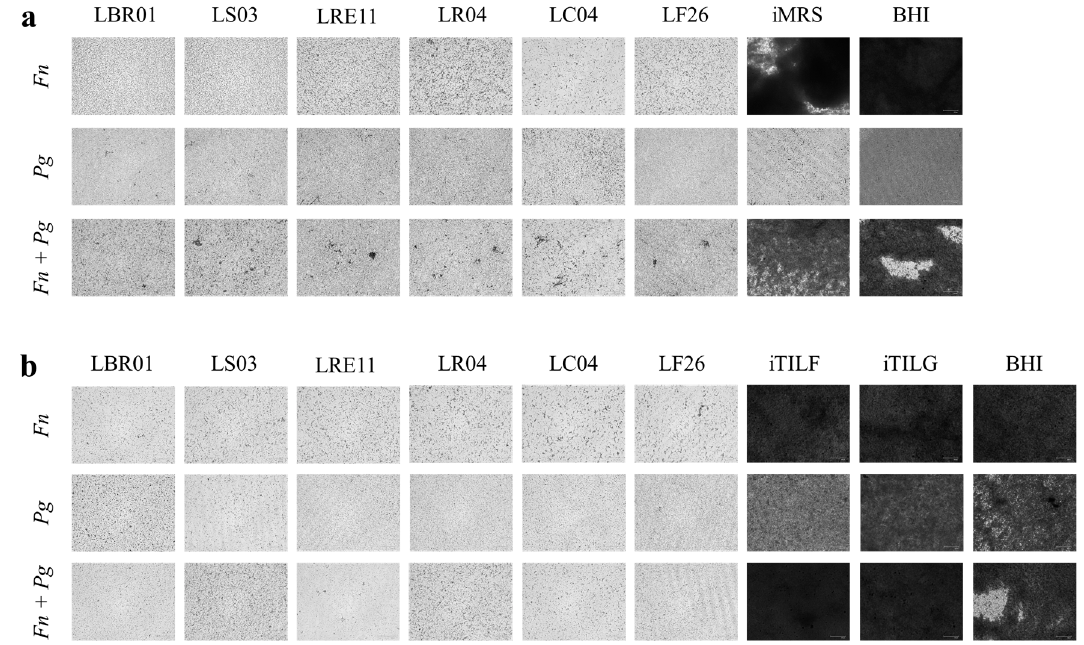
Figure 4. Representative crystal violet (CV) biofilm quantification. Representative CV-stained biofilm images. ( a ) MRS-produced CFS treatment; ( b ) TIL-produced CFS treatment. Images were obtained on a FLoid TM Cell Imaging Station. Magnification 460 × . Fn , F. nucleatum ; Pg , P. gingivalis ; Fn + Pg , F. nucleatum + P. gingivalis .